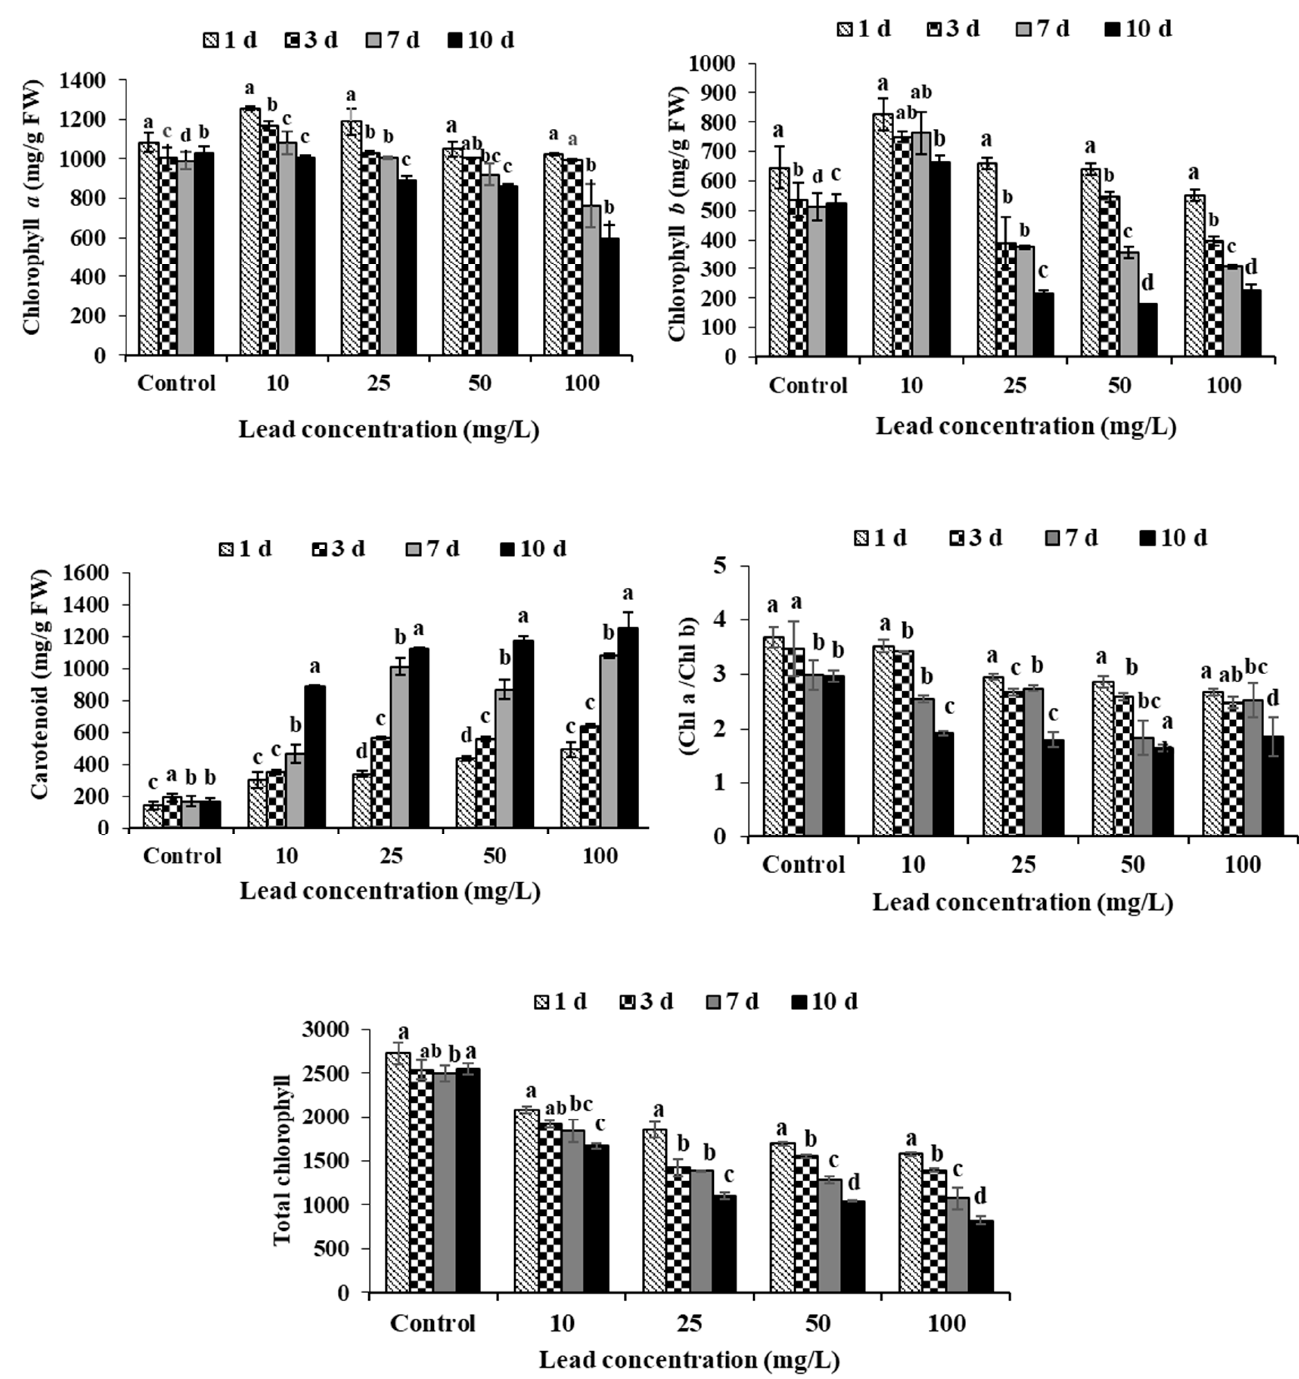
Figure 1. Effects of lead toxicity on photosynthetic pigments content in Ludwigia stolonifera . Means values ± SD ( n = 3). ANOVA was significant at p < 0.05. Different letters indicate significantly different values for a particular treatment group (Tukey’s p < 0.05).